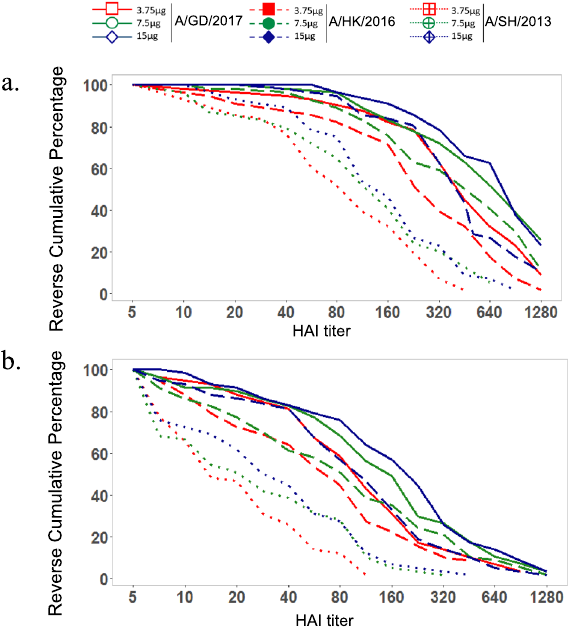
Fig. 4 Adjuvanted recombinant H7 at 3.75, 7.5, and 15 µg doses elicits robust antibody responses in all study groups. Hemagglu- tination inhibition (HAI) antibody responses to homologous A/ Guangdong/17SF003/2016 (H7N9) and heterologous A/Hong Kong/ 125/2017 (H7N9) fi fth epidemic viruses as well as heterologous A/ Shanghai/02/2013 (H7N9) fi rst epidemic virus (days 1 and 50 only) following AS03-adjuvanted recombinant H7 (a) and MF59- adjuvanted recombinant H7 (b) vaccination. Data are shown as geometric mean titer (GMT); 95% con fi dence interval (CI; vertical bars).